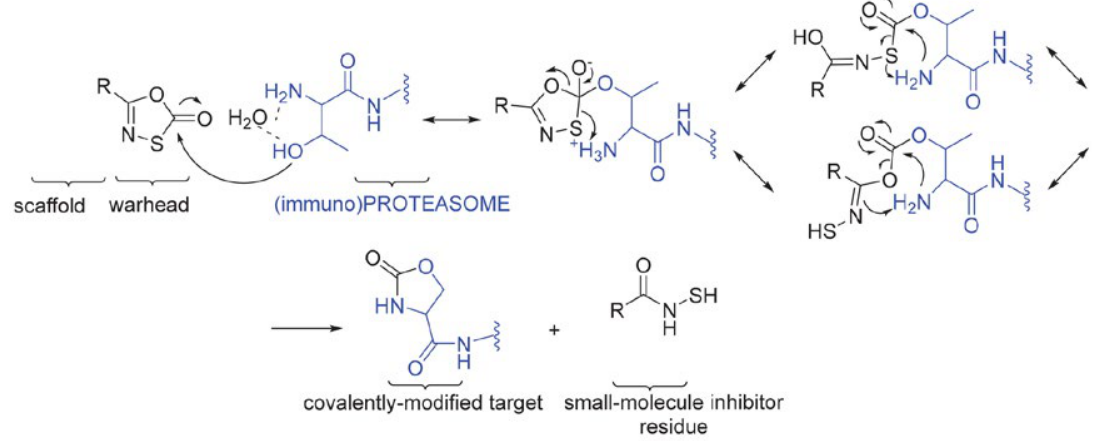
Figure 2. Oxathiazol-2-one electrophilic warhead and its interaction mechanism with the N-terminal threonine in the active site